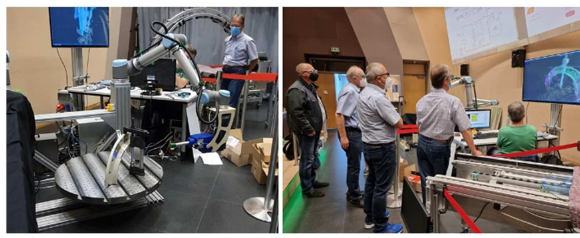
Fig. 6. IGD01 Prototype Setup featuring a Laserscanner and a true-to-scale UHP waterjet